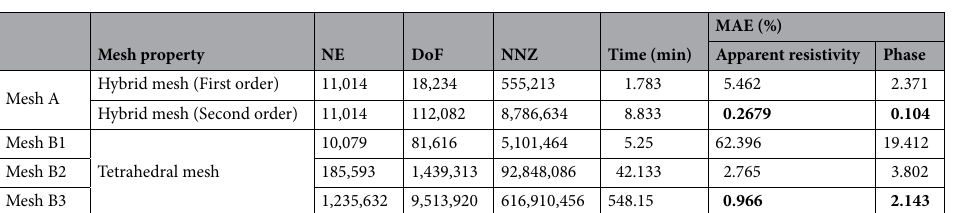
Table 2. Calculation results of different meshes for the three-dimensional layered model. The number of element (NE) represents the total number of all elements in a hybrid or tetrahedral mesh. The DoF number and number of nonzeros (NNZ) reflect the basic situation of the FE system matrix. Based on the semianalytic solution, we use the MAE to measure the misfit of the results generated from different meshes. We provide the memory occupied by the four meshing calculations Significant values are in